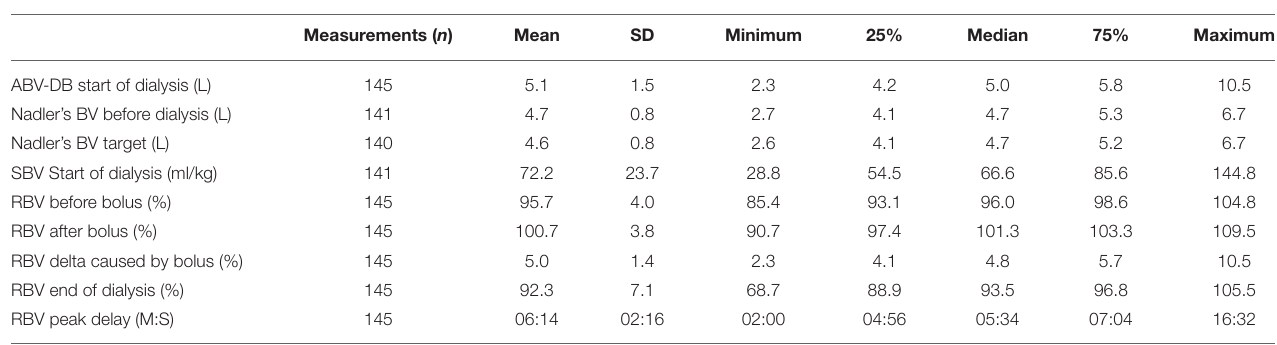
TABLE 3 | ABV-DB (based on 75 patients, 145